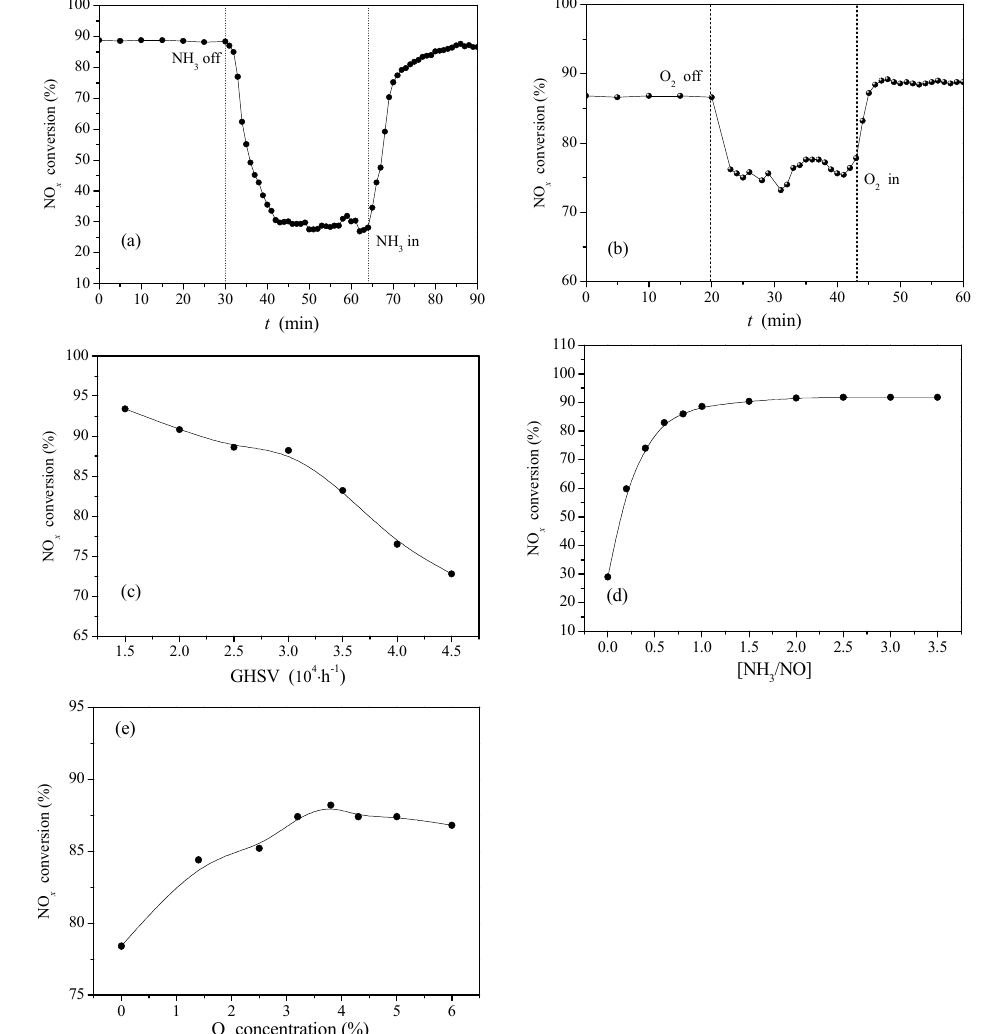
Figure 8. Ce 0.3 /ARM catalyst: ( a ) NH 3 transient response; ( b ) O 2 transient response. Reaction conditions: reaction temperature = 300 °C, reaction gas pressure = 0.1 MPa, N 2 balance, total flow = 2000 mL ∙ min − 1 , GHSV = 30,000 h − 1 , [NH 3 /NO] = 1.0, initial concentration of NH 3 , NO and O 2 = 0.05%, 0.05% and >3.5%, respectively. ( c ) Effect of GHSV. Reaction conditions: reaction temperature = 300 °C, reaction gas pressure = 0.1 MPa, N 2 balance, total flow = 2000 mL ∙ min − 1 , GHSV = 15,000–30,000 h − 1 , [NH 3 /NO] = 1.0, initial concentration of NH 3 , NO and O 2 = 0.05%, 0.05% and >3.5%, respectively. ( d ) Effect of [NH 3 /NO]. Reaction conditions: reaction temperature = 300 °C, reaction gas pressure = 0.1 MPa, N 2 balance, total flow = 2000 mL ∙ min − 1 , GHSV = 30,000 h − 1 , [NH 3 /NO] = 0–3.5, initial concentration of NH 3 , NO and O 2 = 0.05%, 0.05% and >3.5%, respectively. ( e ) Effect of O 2 volume fraction. Reaction conditions: reaction temperature = 300 °C, reaction gas pressure = 0.1 MPa, N 2 balance, total flow = 2000 mL ∙ min − 1 , GHSV = 30,000 h − 1 , [NH 3 /NO] = 0–3.5, initial concentration of NH 3 , NO and O 2 = 0.05%, 0.05% and 0~6%, respectively.